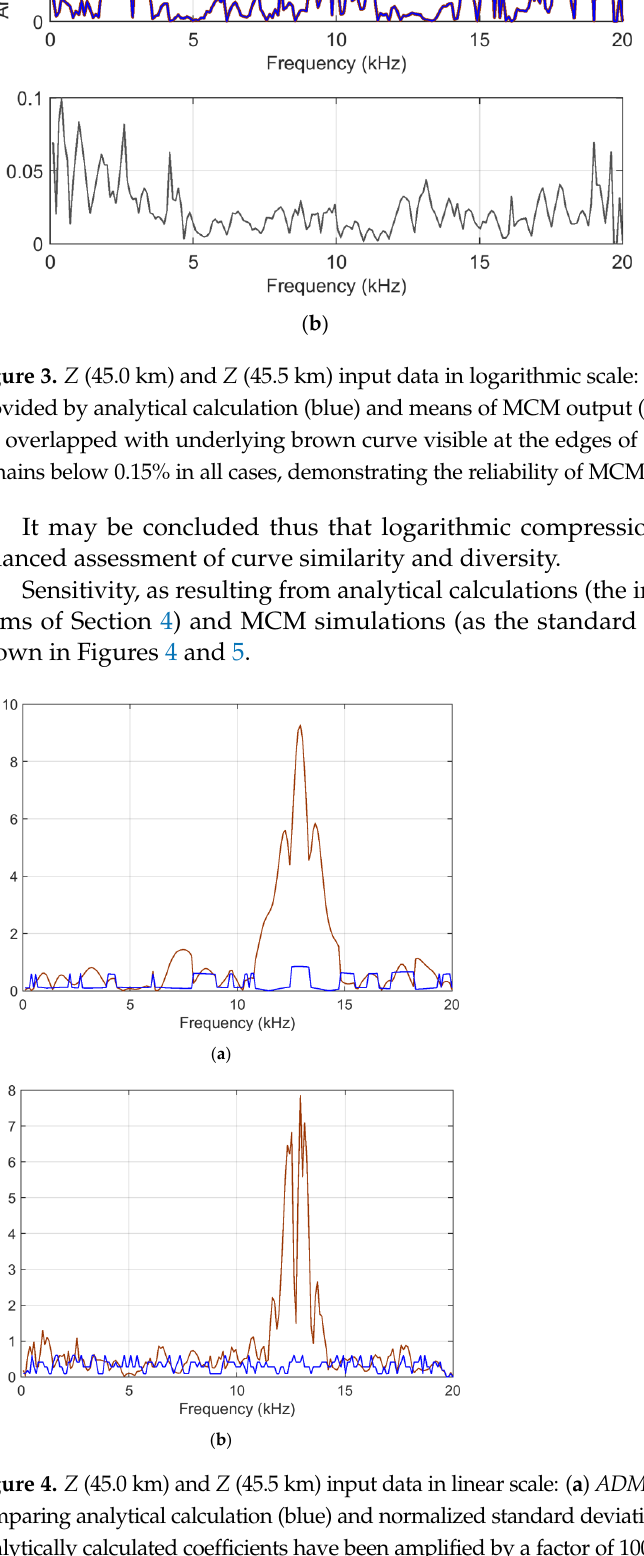
Figure 4. Z (45.0 km) and Z (45.5 km) input data in linear scale: ( a ) ADM i and ( b ) FDM i sensitivity curves, comparing analytical calculation (blue) and normalized standard deviation of MCM output (brown). The analytically calculated coefficients have been amplified by a factor of 100 for a matter of visibility. As already observed, for the linear case, both the ADM i and FDM i quantities, and their sensitivity coefficients as well, have maximum values where the data is at the highest peak, at around 12 kHz. This confirms that all such quantities are not normalized, and suffer scale problems. By comparing Figure 4 (where the blue curve is amplified by a factor 100) and Figure 5, it is evident that providing data in the linear or logarithmic scale has a dramatic influence on the behavior of sensitivity: in this latter case, with logarith- mic compression, the analytic and MCM curves are closer. This means that the problem with the logarithmic scale is formulated in a way that favors the analytic calculation of the sensitivity coefficients, and that in general, the sensitivity is lower, as confirmed by the MCM results, which are smaller by a factor of 4 – 5 and more uniform.